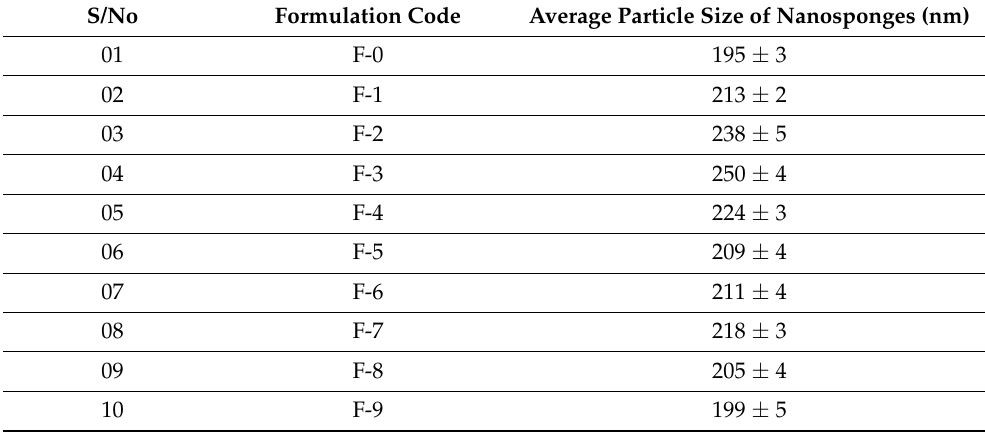
Table 1. Average particle size of the developed nanosponges.